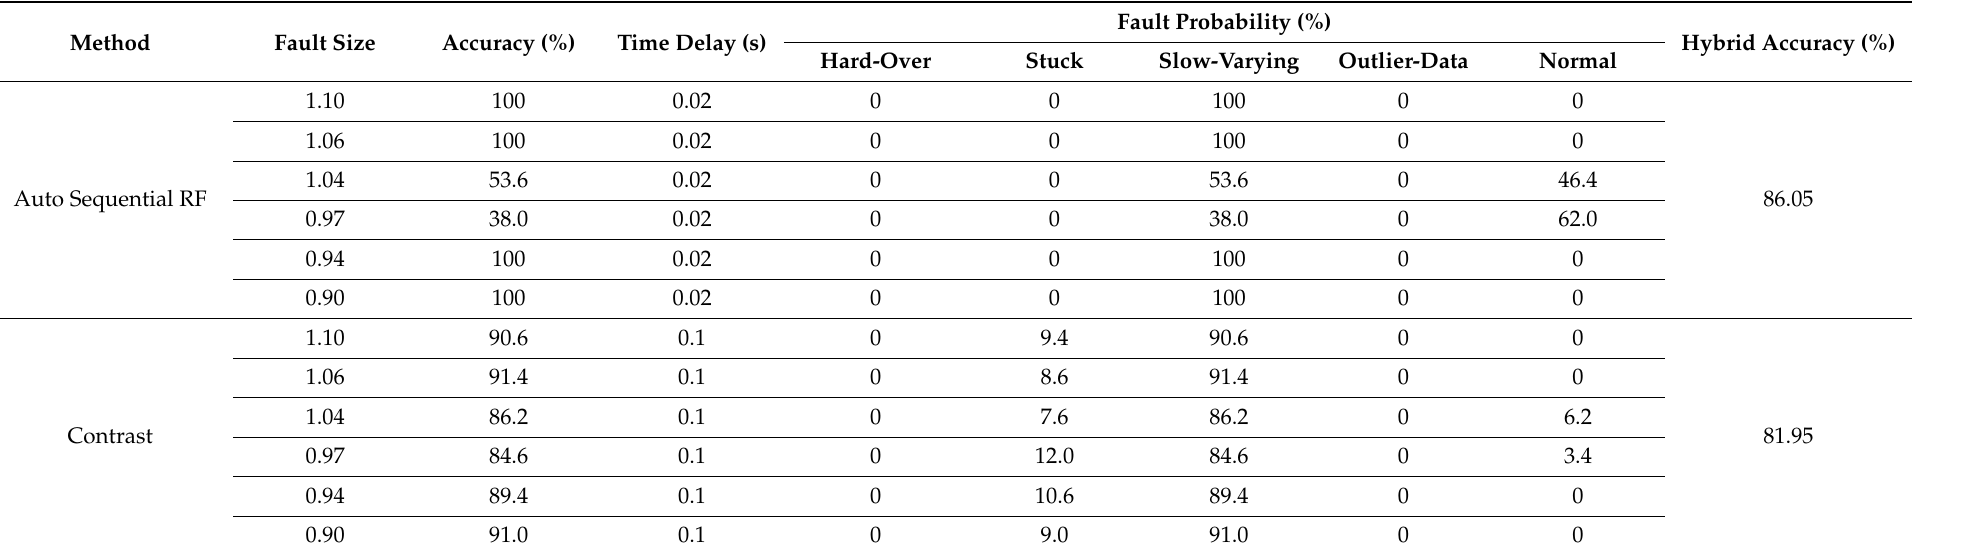
Table 6. Real-time fault diagnosis result of the slow-varying fault.